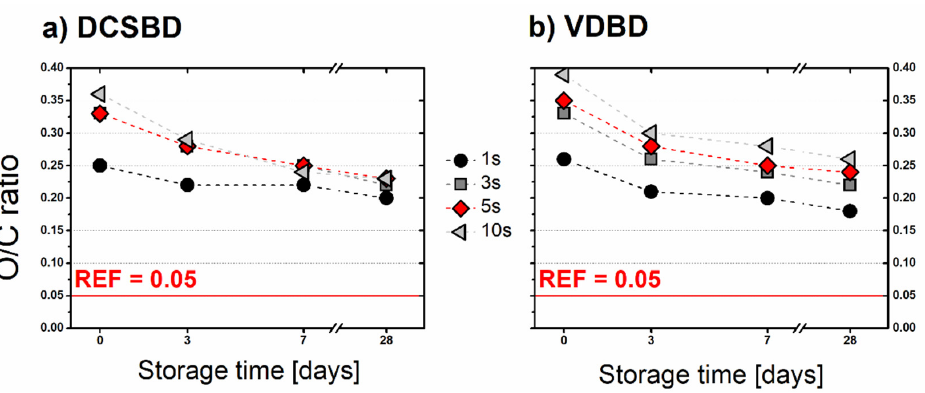
Figure 7. Development of the O/C ratio during the storage of BOPP foils under laboratory conditions: O/C ratio plotted against the storage time for ( a ) DCSBD and ( b ) VDBD for all plasma treatment conditions.